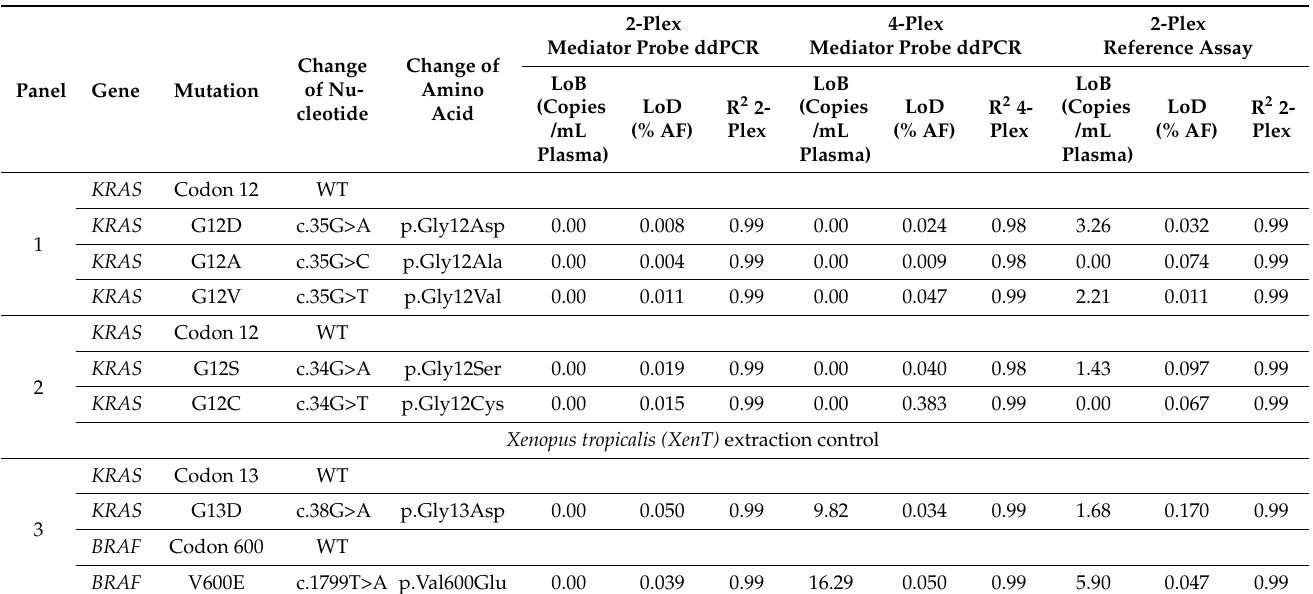
Table 1. Characterization of 2-plex and 4-plex MP ddPCR assays (LoB, LoD, and R 2 ) on Stilla Naica system. Comparison to reference LNA assays on the Bio-Rad